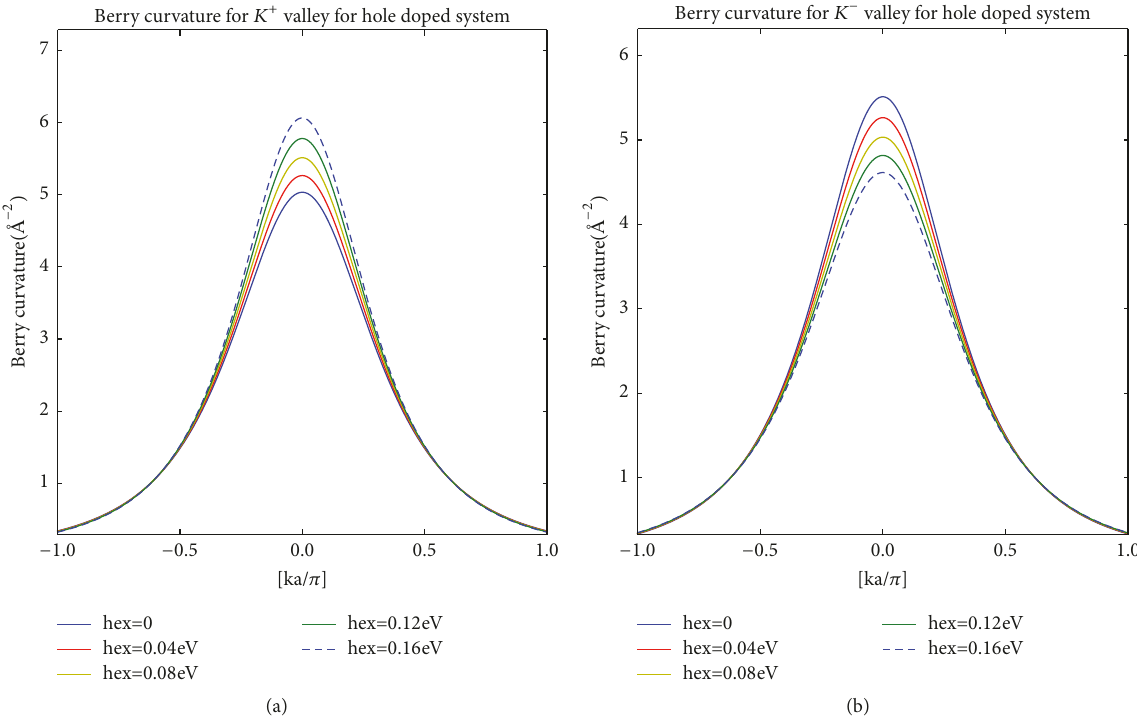
Figure 2: Berry curvature as function of ( 𝑘𝑎/𝜋 ) for different values of exchange fields (h 𝑒𝑥 ), right panel for K + , and left panel for K − valley.